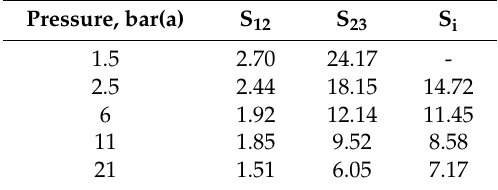
Table 6. Effect of hydrogen pressure on selectivities S 12 , S 23 and S i for the INS Ni_C